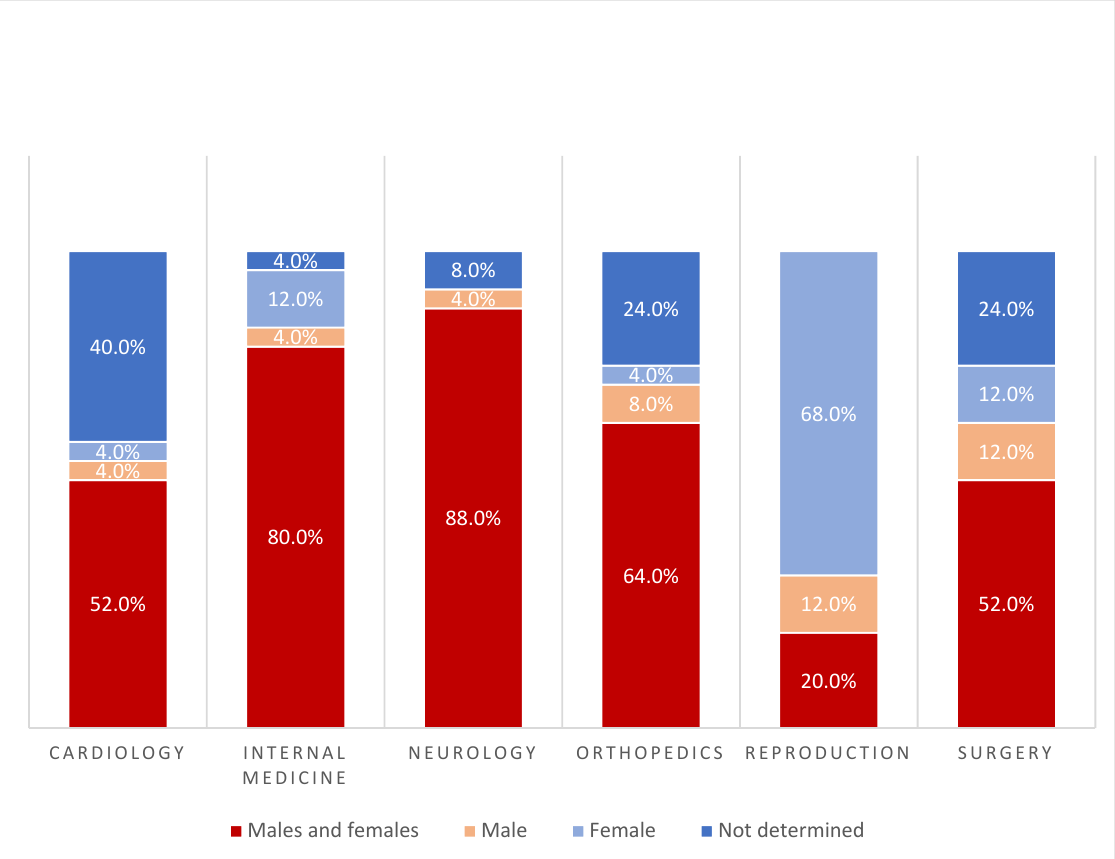
Figure 1. Sex of the dogs utilized in 150 clinical trials within six veterinary specialties (25 each). Spay and neuter status of the study population. T he spay and neuter status of most dogs used in the 150 studies was not specified in 38.7% of the studies (Figure 2). In four studies (2.7%), all dogs used in the trial were neutered. In 34.7% of the studies, both neu- tered and intact dogs were used, and in 24.0% of the studies, all dogs were intact. Except for studies in the field of reproduction, the neuter status was not specified as an inclusion or exclusion criterion. In 23 studies (92.0%) belonging to the reproductive field, intact dogs were enrolled ( p < 0.05). In 18 neurology studies (72.0%) and 13 internal medicine (52.0%) studies, both neutered and non-neutered dogs were used. The spay and neuter status of the dogs used was not specified in 16 (64.0%) studies each on cardiology and orthopae- dics.